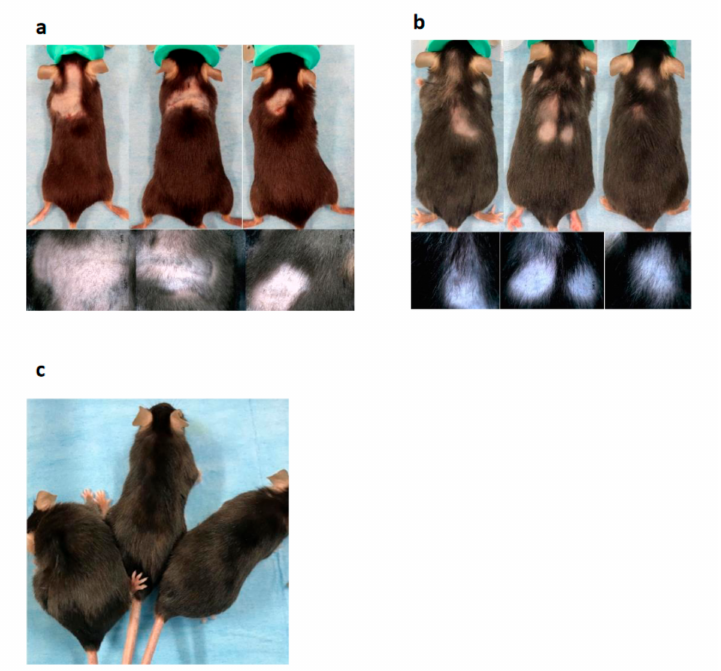
Figure 2. Macroscopic findings and dermoscopic findings. ( a ) Eight weeks after the WAS test, 25% of cchcr1 − / − mice showed localized hair loss. Short stubs of hair and exclamation mark hairs were seen under dermoscopy. ( b ) Eighteen weeks after the WAS test on cchcr1 − / − mice. Recovery from localized hair loss was evident, but the prognosis was variable, and AA-like lesions recurred in some mice. Thin hairs and white hairs were observed under dermoscopy. ( c ) WT mice after the WAS test. Table 1. The numbers of mice with AA-like skin lesions after the WAS test. Observation Period